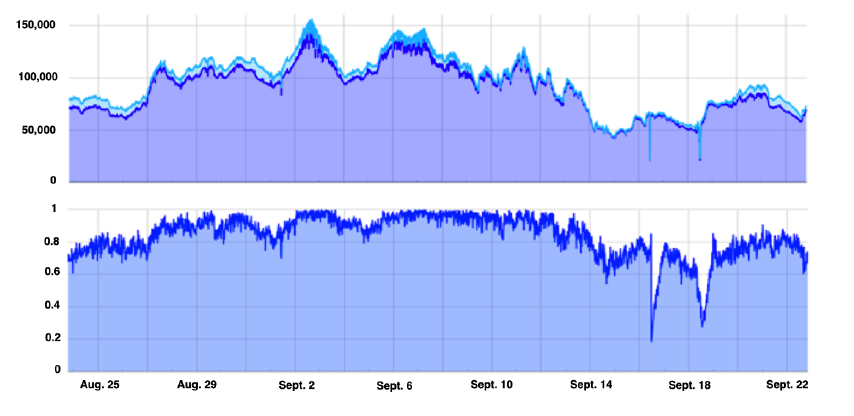
Figure 2. Total number of dynamic slots in the Global Pool (top) and collector duty cycle percentage (bottom). It can be observed that the collector reaches saturation load when the number of slots in the pool approaches